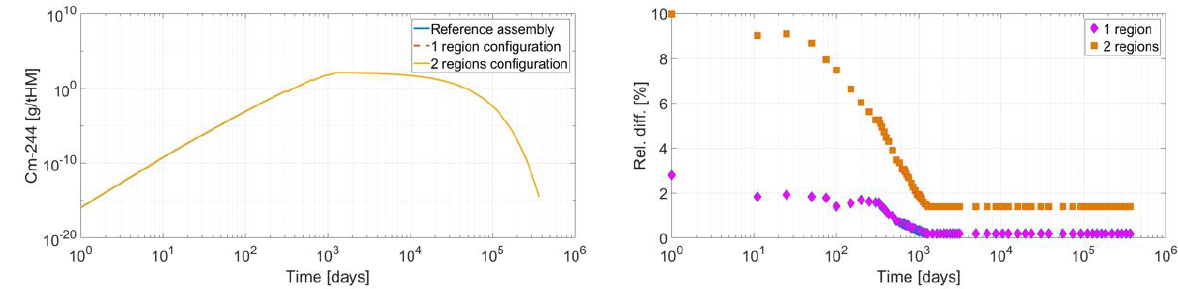
Figure 14. 244 Cm masses as a function of irradiation + subsequent cooling time for different assembly configurations with respect to the